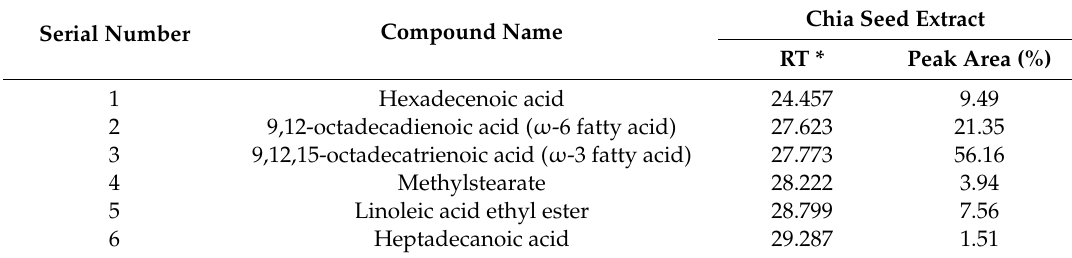
Figure 1. Gas chromatography-mass spectrometry (GC-MS) data for the fatty acid composition analysis of chia seed extract. Table 2. Fatty acid composition analysis of chia seed extract using GC-MS showing 99%–95% similarity in the